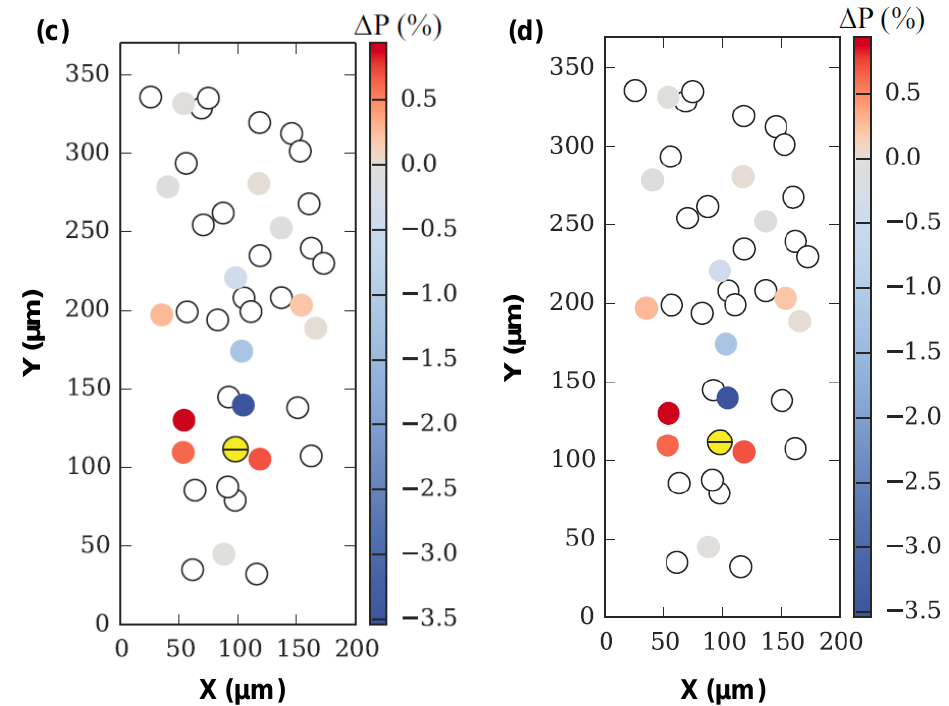
Figure 9. ( a – d ) Shows the distribution of ∆ P of the centroids of un-cracked particles after four di ff erent particles have fractured. Previously cracked particles are denoted in solid white circles. The newly cracked particle are denoted in a solid yellow circle with a black break surface. Un-cracked particles are colored by the change of Weibull fracture probability before and after fracture.